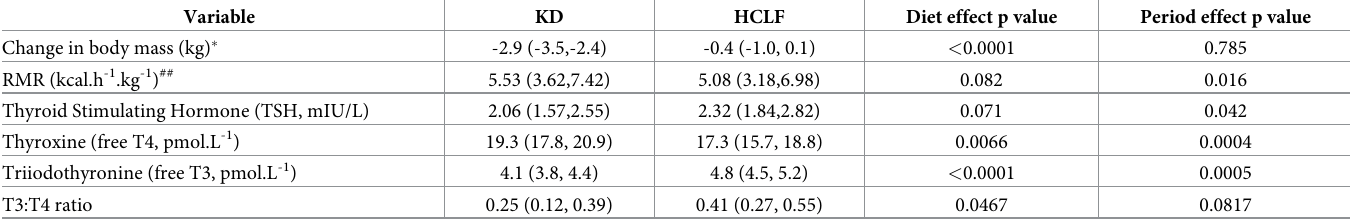
Table 3. Outcome measures of change in body mass and thyroid function between the two dietary interventions (n = 11).